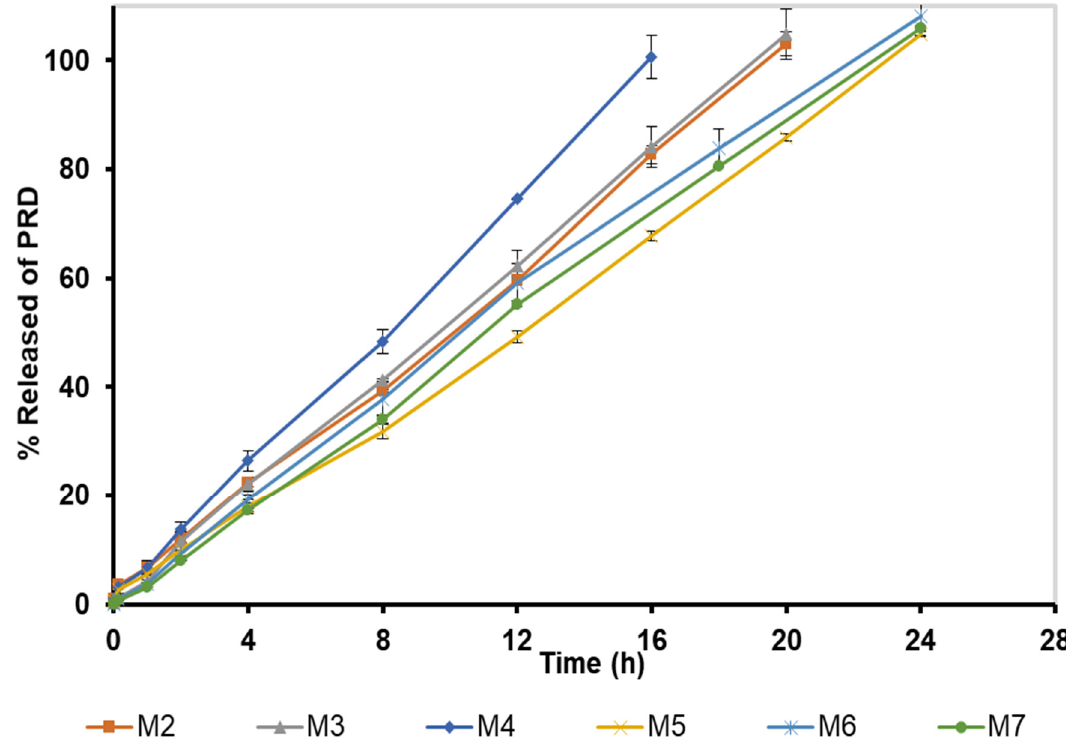
Figure 10. In vitro release profiles of M 2-7 microgels through 24 h at 35 °C